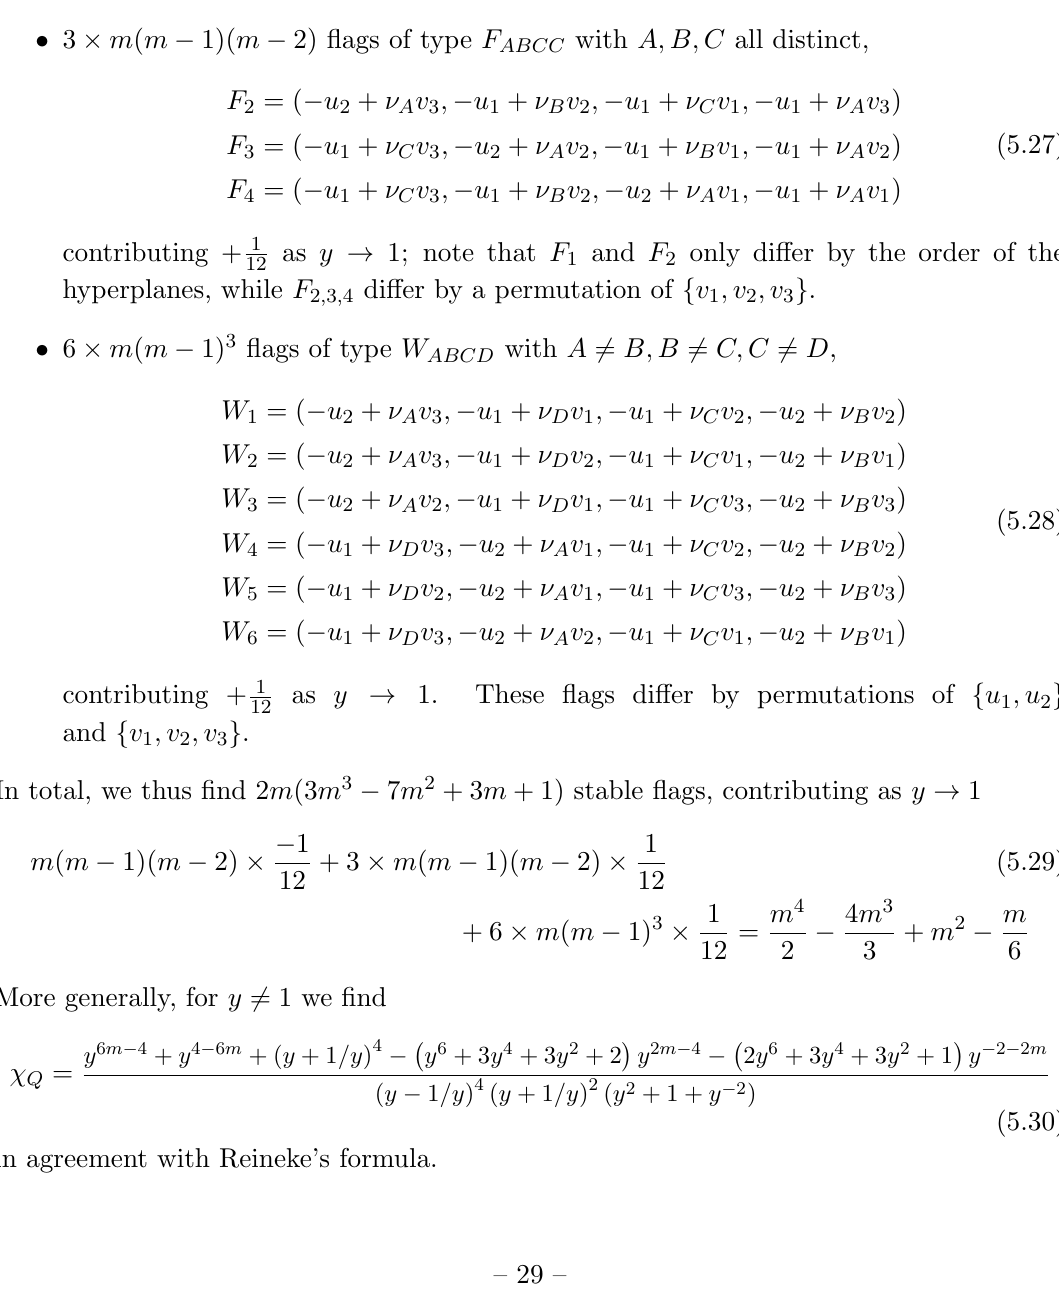
Figure 2 . Graphs associated to the (cid:13)ags contributing to the equivariant (cid:31) -genus of the Kronecker quiver K m (2 ; 3) (up to permutations of f u s g and f v s 0 g